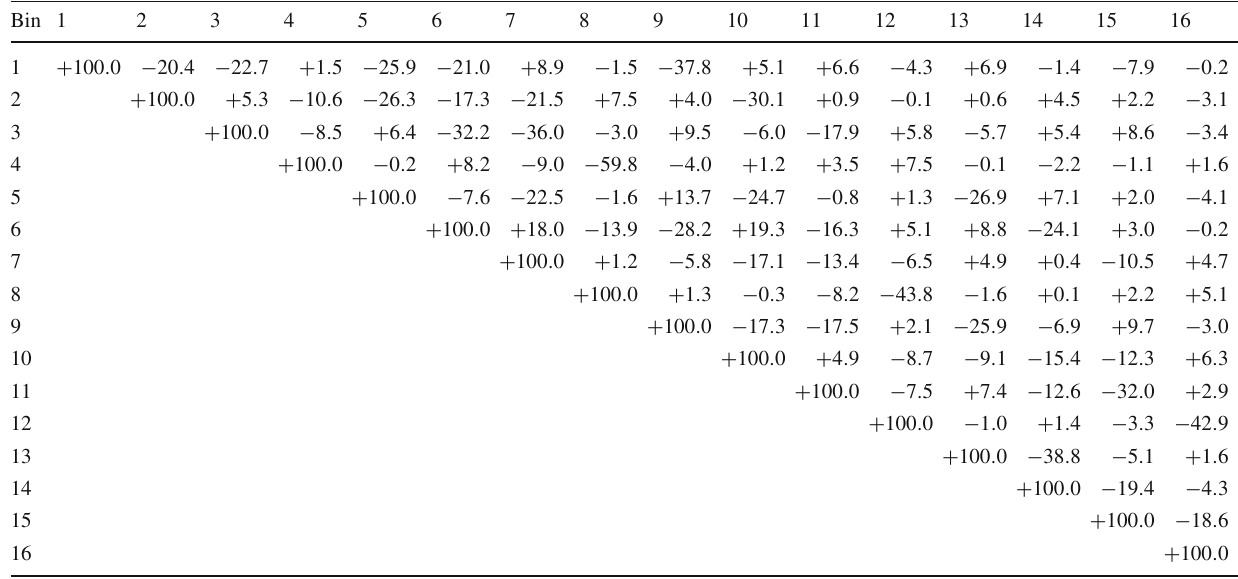
Table 18 The correlation matrix of statistical uncertainties for the normalized tt double-differential cross sections as a function of M ( tt ) and p T ( tt ) . The values are expressed as percentages. For bin indices see Table 17 Bin